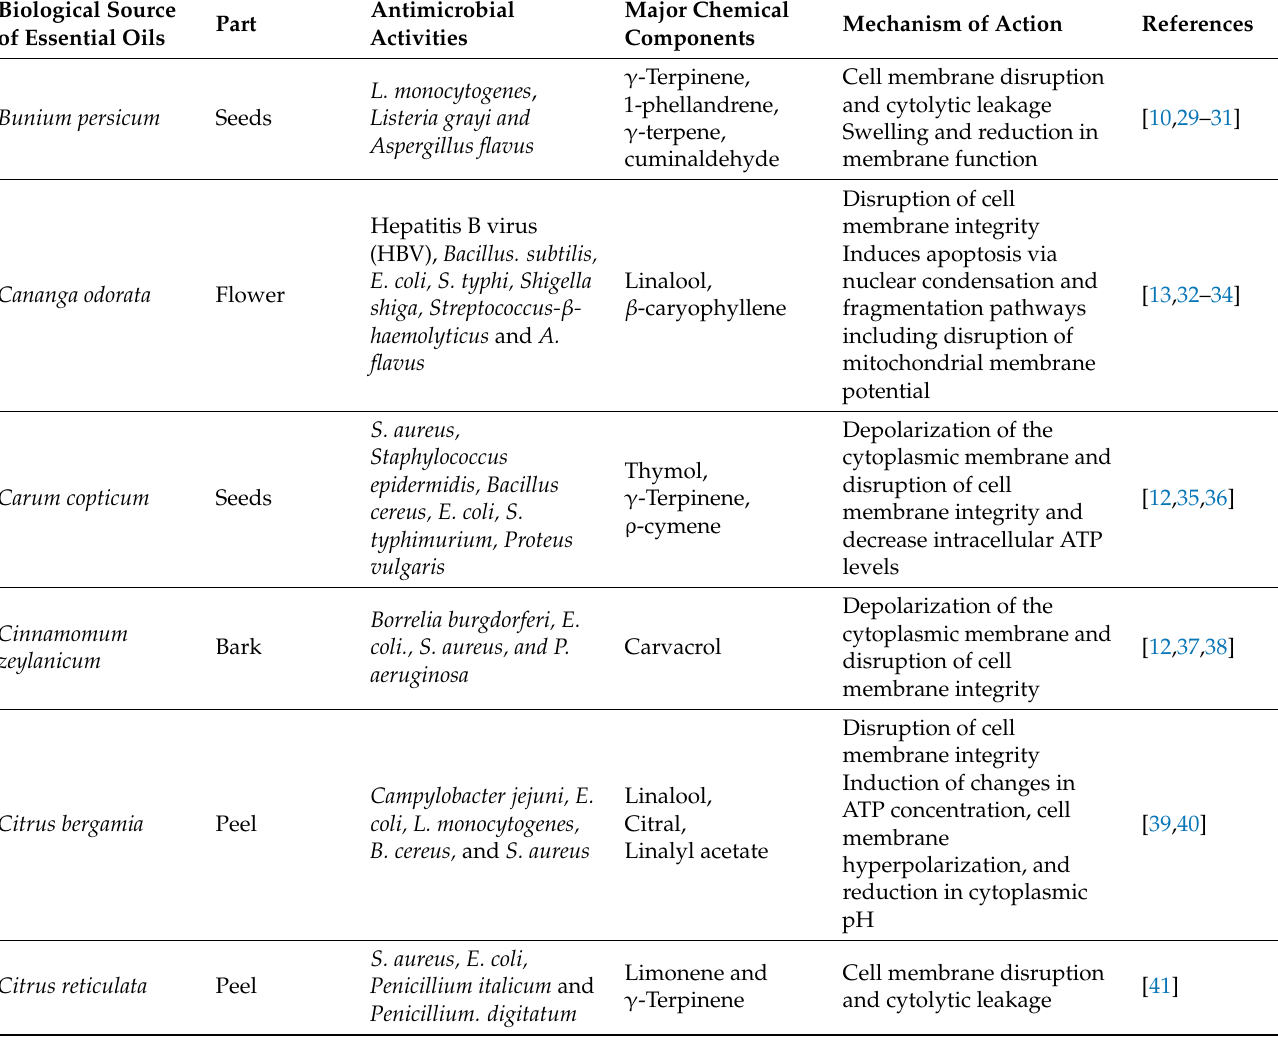
Table 1. Major chemical components of essential oils and their antimicrobial